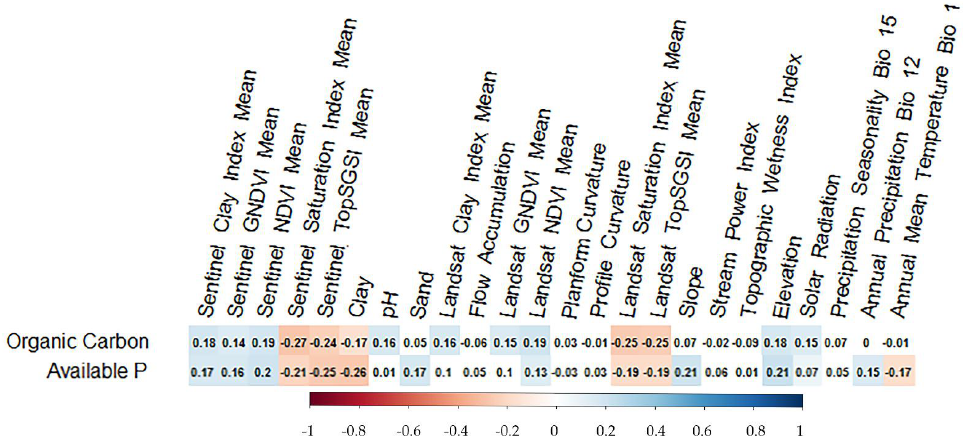
Figure 4. Pearson correlation coefficient values of dependent variables (soil properties) with predic- tive environmental variables ( p < 0.05).